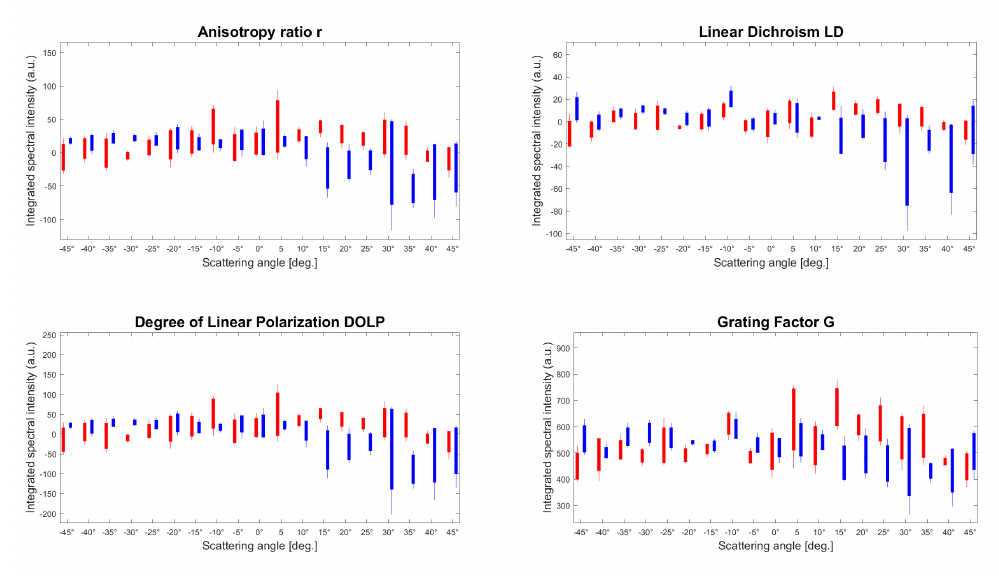
Figure 7. Multidimensional estimation of the four parameters integrated over the whole spectra with the three ROIs per tissue type. The parameters r , LD , DOLP , and G correspond to the anisotropy ratio, the linear dichroism, the degree of linear polarization, and the grating factor, respectively. The three spectral integrated values have been reported in a single bar where the red and blue correspond to the connective/muscular and tendon tissues areas,